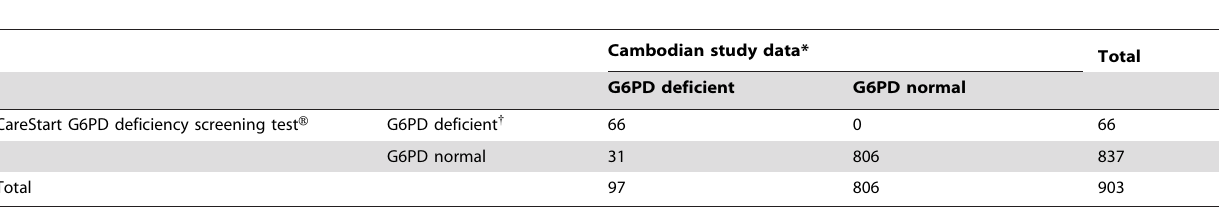
Table 3. Results of the CareStart TM G6PD deficiency screening test H and the quantitative G6PD assay from 903 individuals, Pailin province, Cambodia,